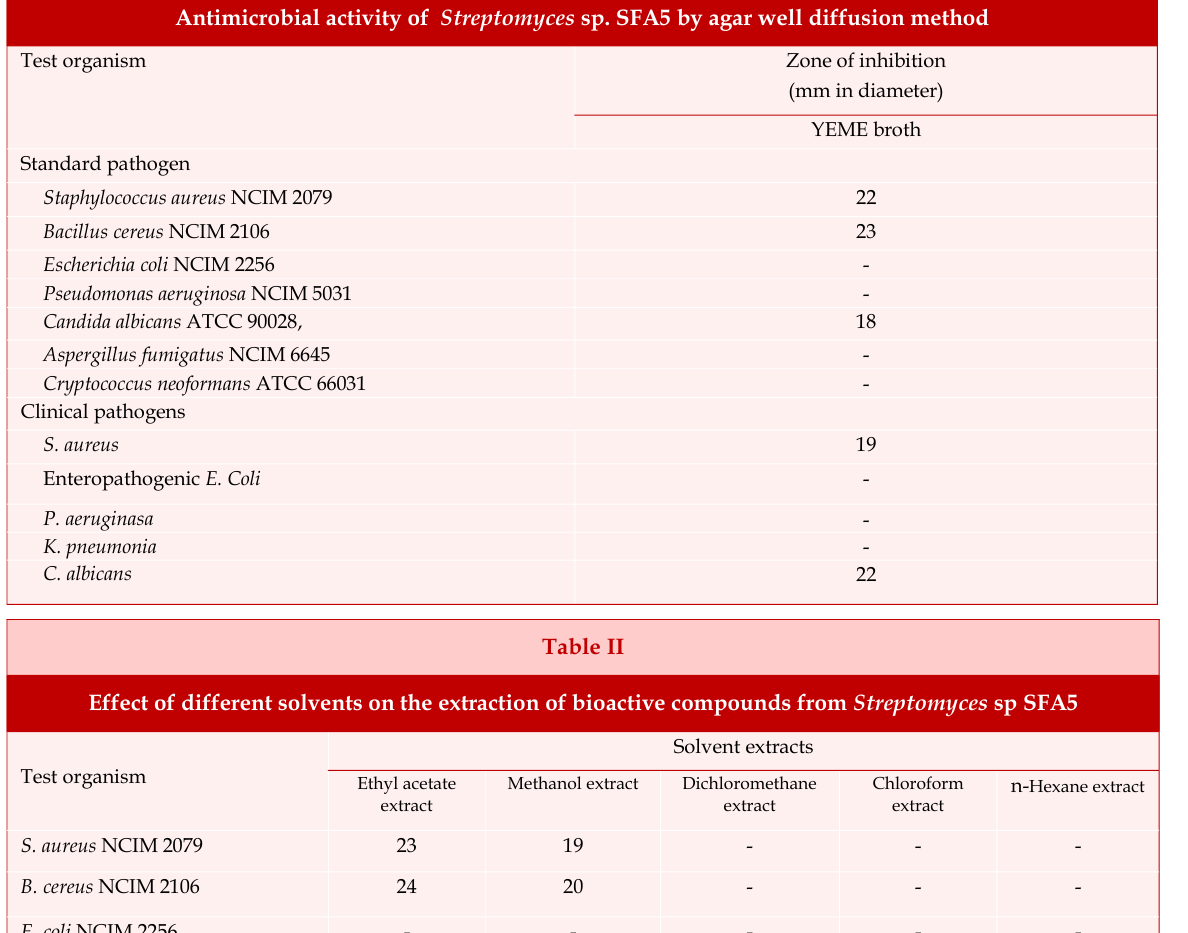
Antimicrobial activity of Streptomyces sp. SFA5 by agar well diffusion method